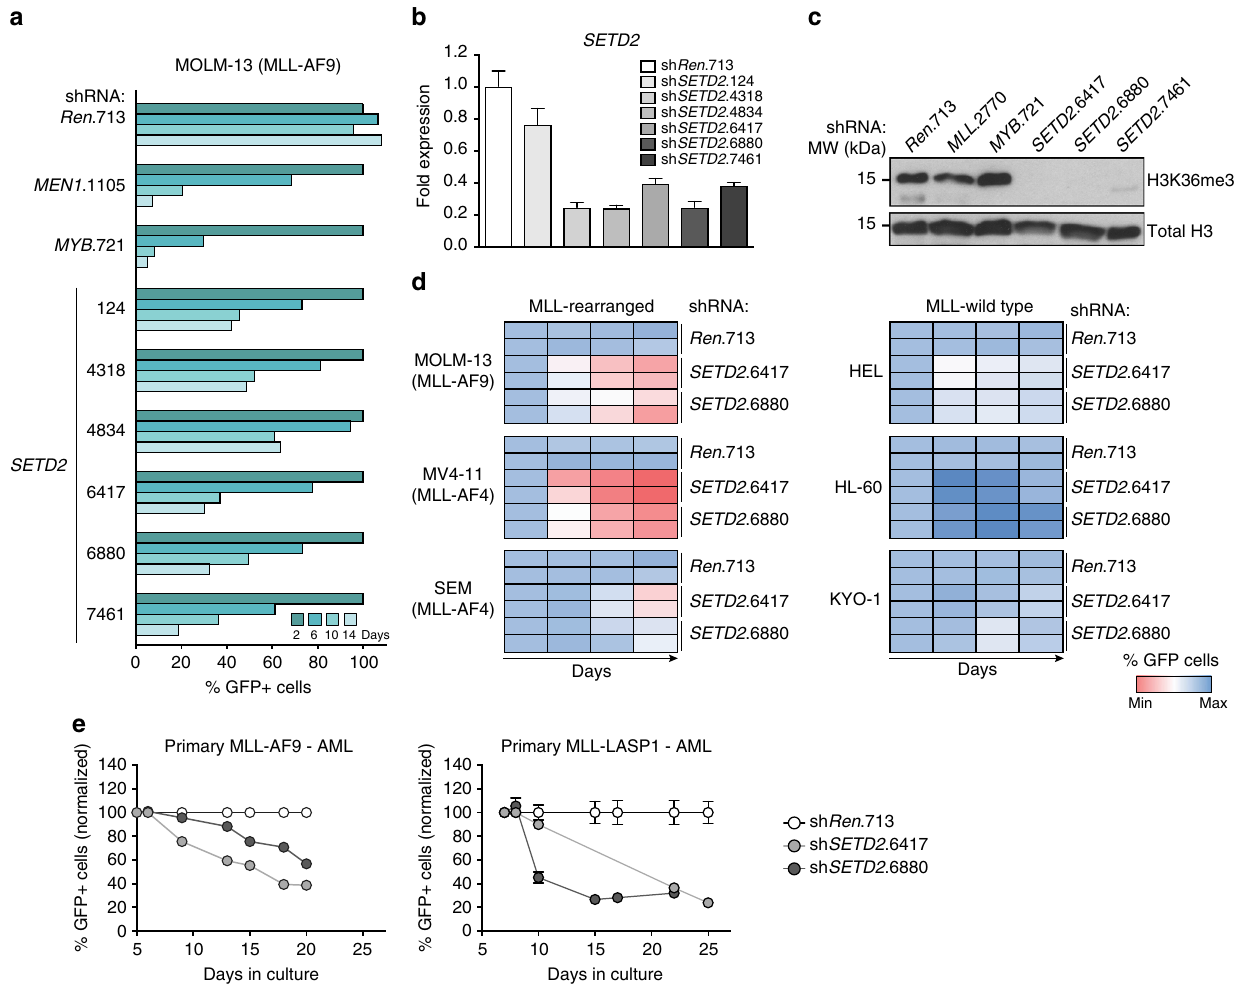
Fig. 3 SETD2 is required for proliferation of MLL-leukemia cells. a Results of FACS-based competitive proliferation assay shown as the percentage of GFP- positive MOLM-13 cells expressing individual SETD2 -targeting shRNAs in the presence of Dox over 14 days. One representative experiment of four is shown. b qPCR analysis of SETD2 mRNA levels in MOLM-13 cells expressing indicated shRNAs after 48 h of Dox treatment (mean ± s.d. n = 3). c Western blot analysis of H3K36me3 levels in MOLM-13 cells expressing indicated shRNAs after 72 h of Dox treatment. d Heatmap representation of competitive proliferation assays performed in human cell lines harboring MLL rearrangements (left) vs. MLL-wild-type cells (right) expressing indicated shRNAs targeting SETD2 as described in a . Representative results of two out of three experiments are shown. e Time course of GFP expression of primary human AML cells from patients expressing MLL-AF9 and MLL-LASP1 fusion genes expressing indicated shRNAs (mean ± s.d. n =